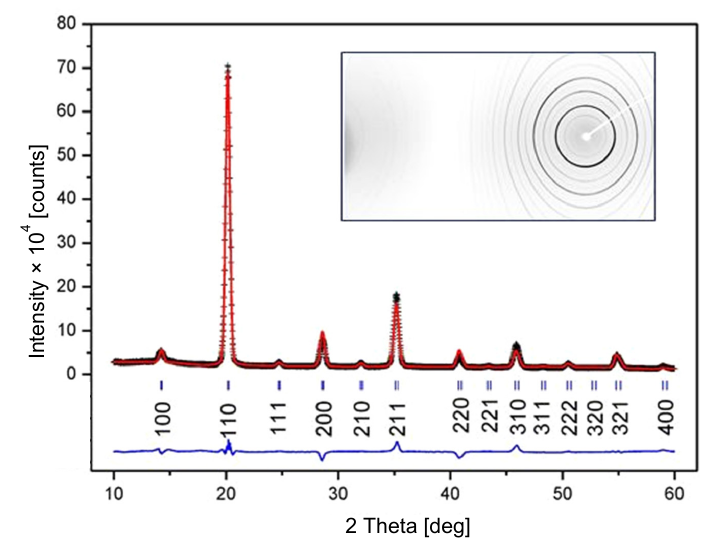
Figure 1. Two-dimensional X-ray diffraction pattern for Co 2 MnAl ribbon (transmission geometry), with the measured pattern consequently converted into a one-dimensional intensity vs. diffraction angle dependence and processed by standard procedures for qualitative phase analysis and the Rietveld crystal structure refinement method. The phase composition of the sample has been found to be single phase AlCo 2 Mn (the Fm3-m space group, JCPDS card No: